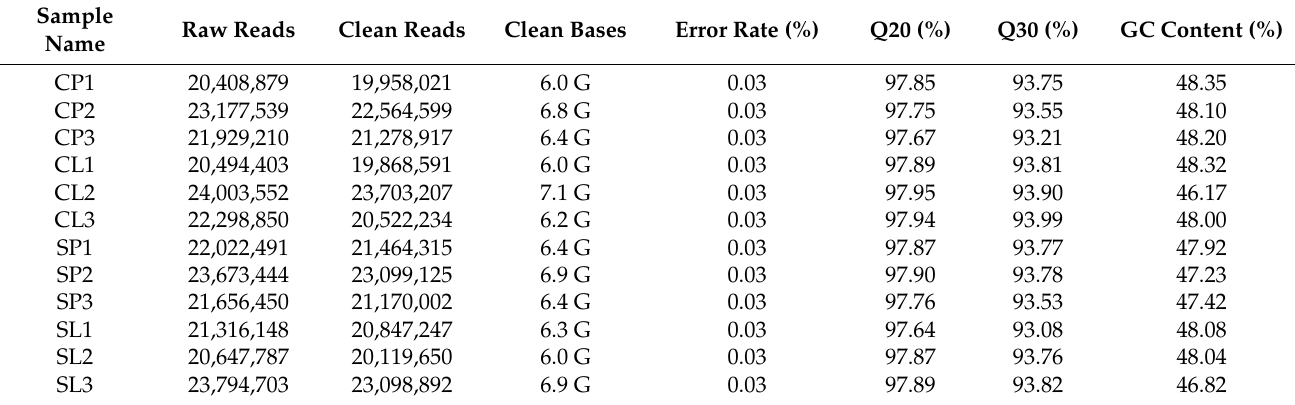
Table 1. Sequence statistics of N. ‘Colorado’ under salt stress.